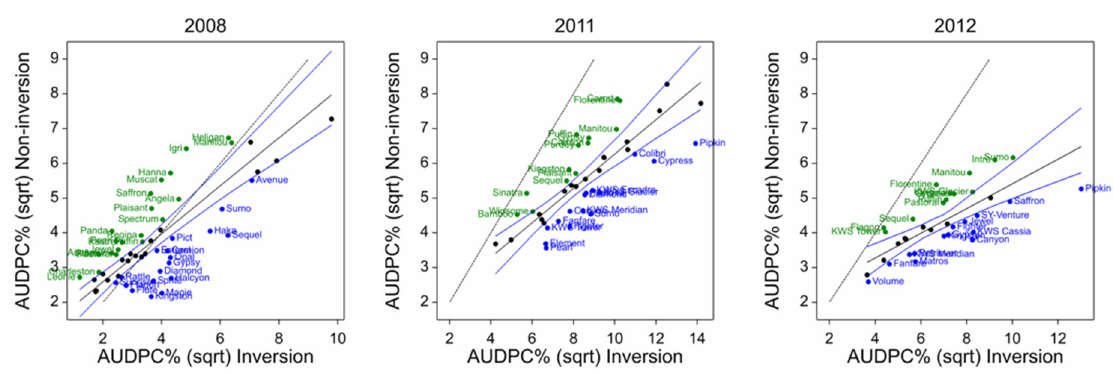
Figure 13. Regression of non-inversion on inversion rhynchosporium %AUDPC (sqrt) for the 2008, 2011 and 2012 trials. The blue lines show the 95% confidence interval of the regression line (solid black), while the dashed line shows the 1:1 yield ratio. Only cultivars outside the confidence limits are labelled for clarity, blue below and green above. Table 16. Ranking of winter barley cultivars grown in the 2008, 2011 and 2012 trials by the difference between their inver- sion and non-inversion area under their rhynchosporium disease progress curve (%AUDPC)(sqrt) ranking that change rank by more than 13 places.